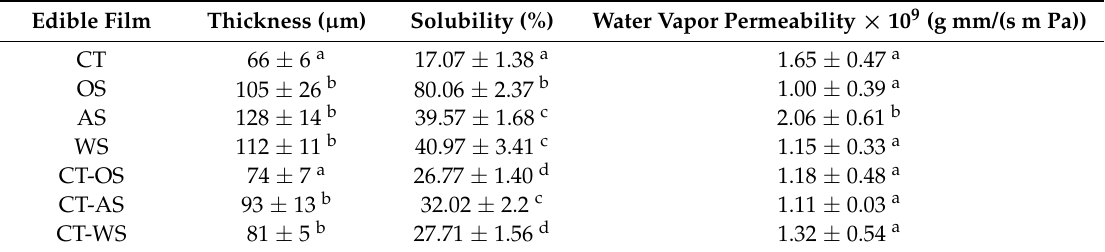
Table 2. Physical properties of edible films made from CH-only, starches-only and mixtures CH-starches (1:3 w / w ) ratio,